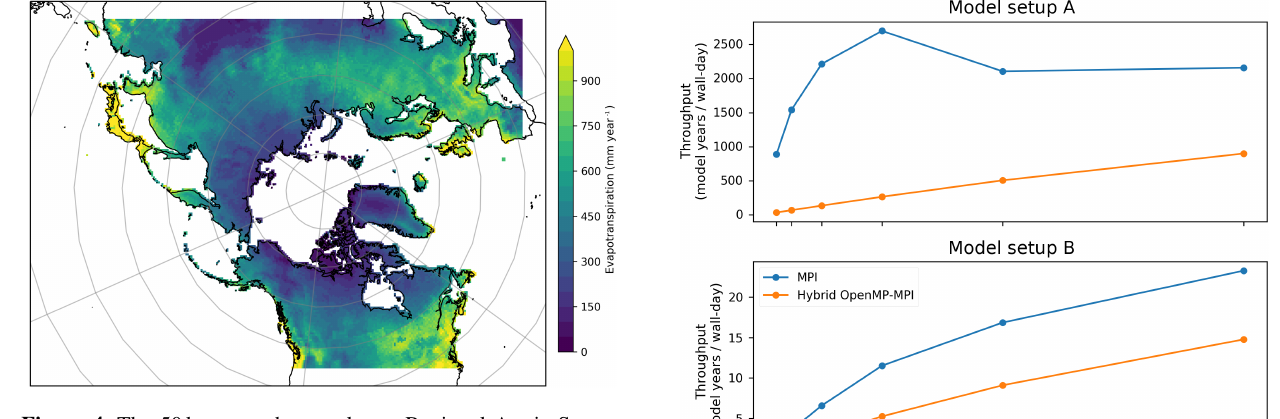
Figure 4. The 50km near the equal-area Regional Arctic System Model (RASM) domain. The model domain is comprised of 25996 grid cells. Shading denotes mean annual evapotranspiration from a test simulation run with model configuration (B) as described in Sect. 3. Figure 5. Model throughput for the two model configurations de- scribed in Sect. 3 run on the Thunder (SGI Ice X) supercom- puter. The MPI-only simulations are shown in blue and the hybrid OpenMP-MPI simulations are shown in